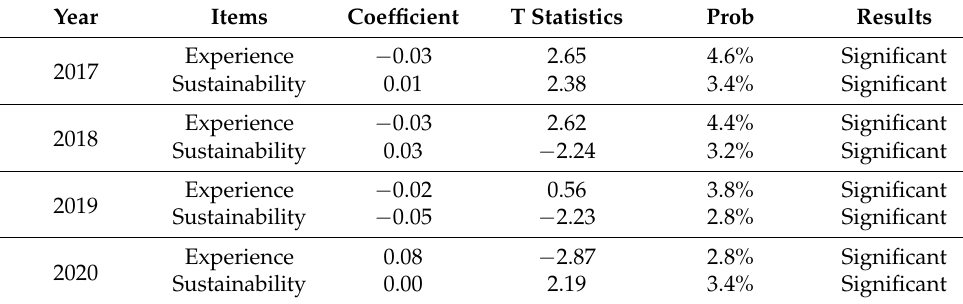
Table 10. Interpretation of long run coefficient (5% significance